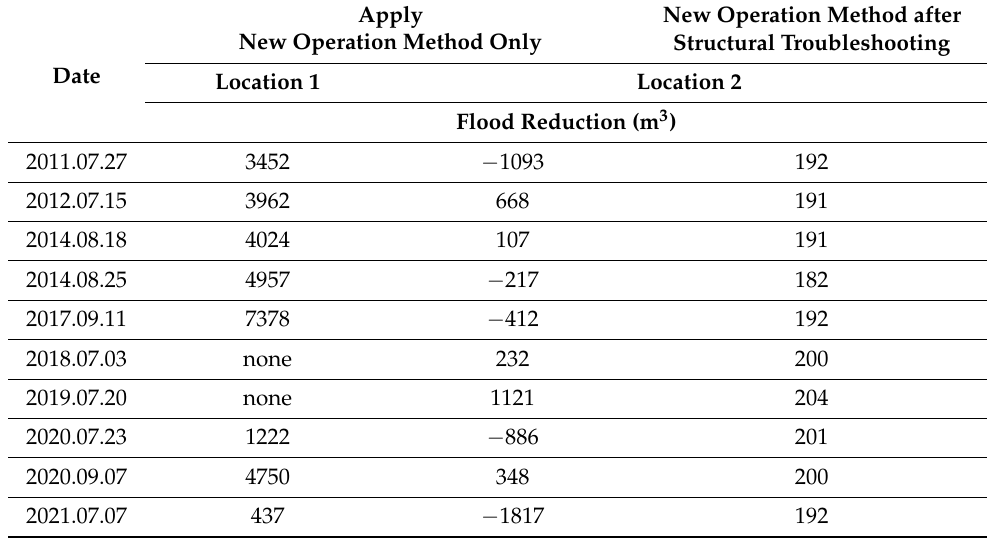
Table 4. Flood reduction values.